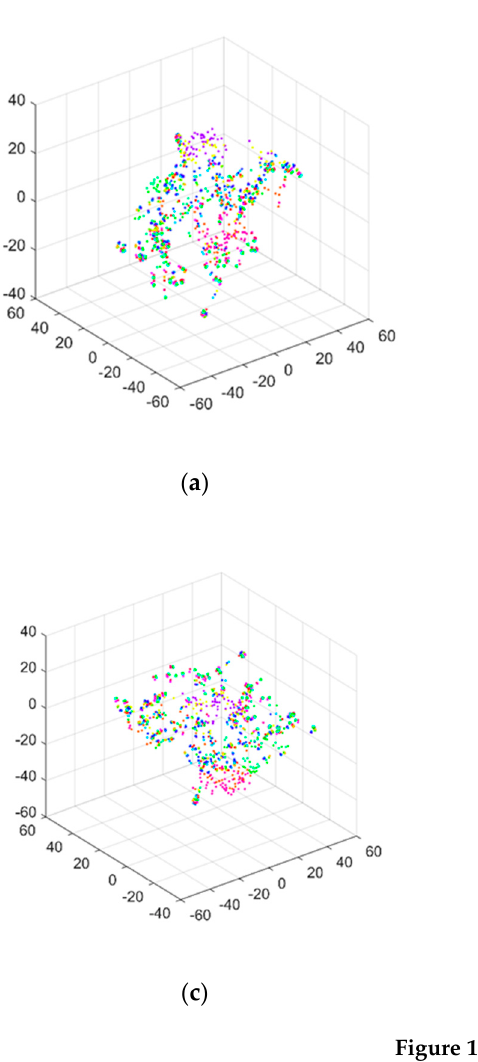
Figure 13. Visualization results of signal features in the TSs extracted by the 1D CNN model under the noise levels of SNR = ( a ) 50, ( b ) 40, ( c ) 35, ( d ) 30, ( e ) 25, ( f ) 20, ( g ) 15, and ( h ) 10 dB.